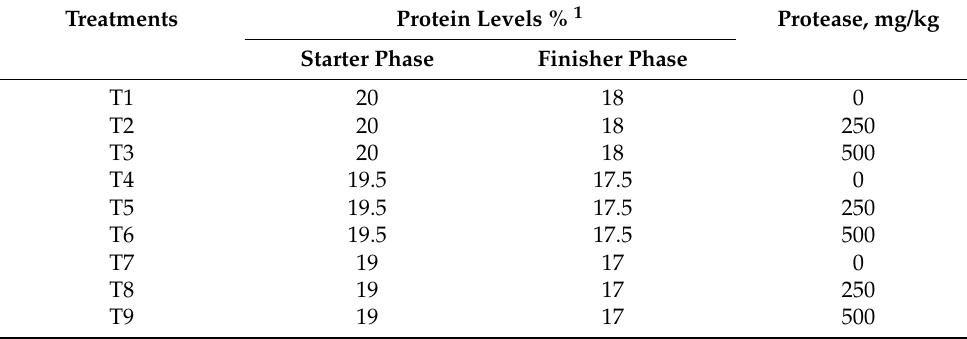
Table 1. Experimental design and dietary treatments.